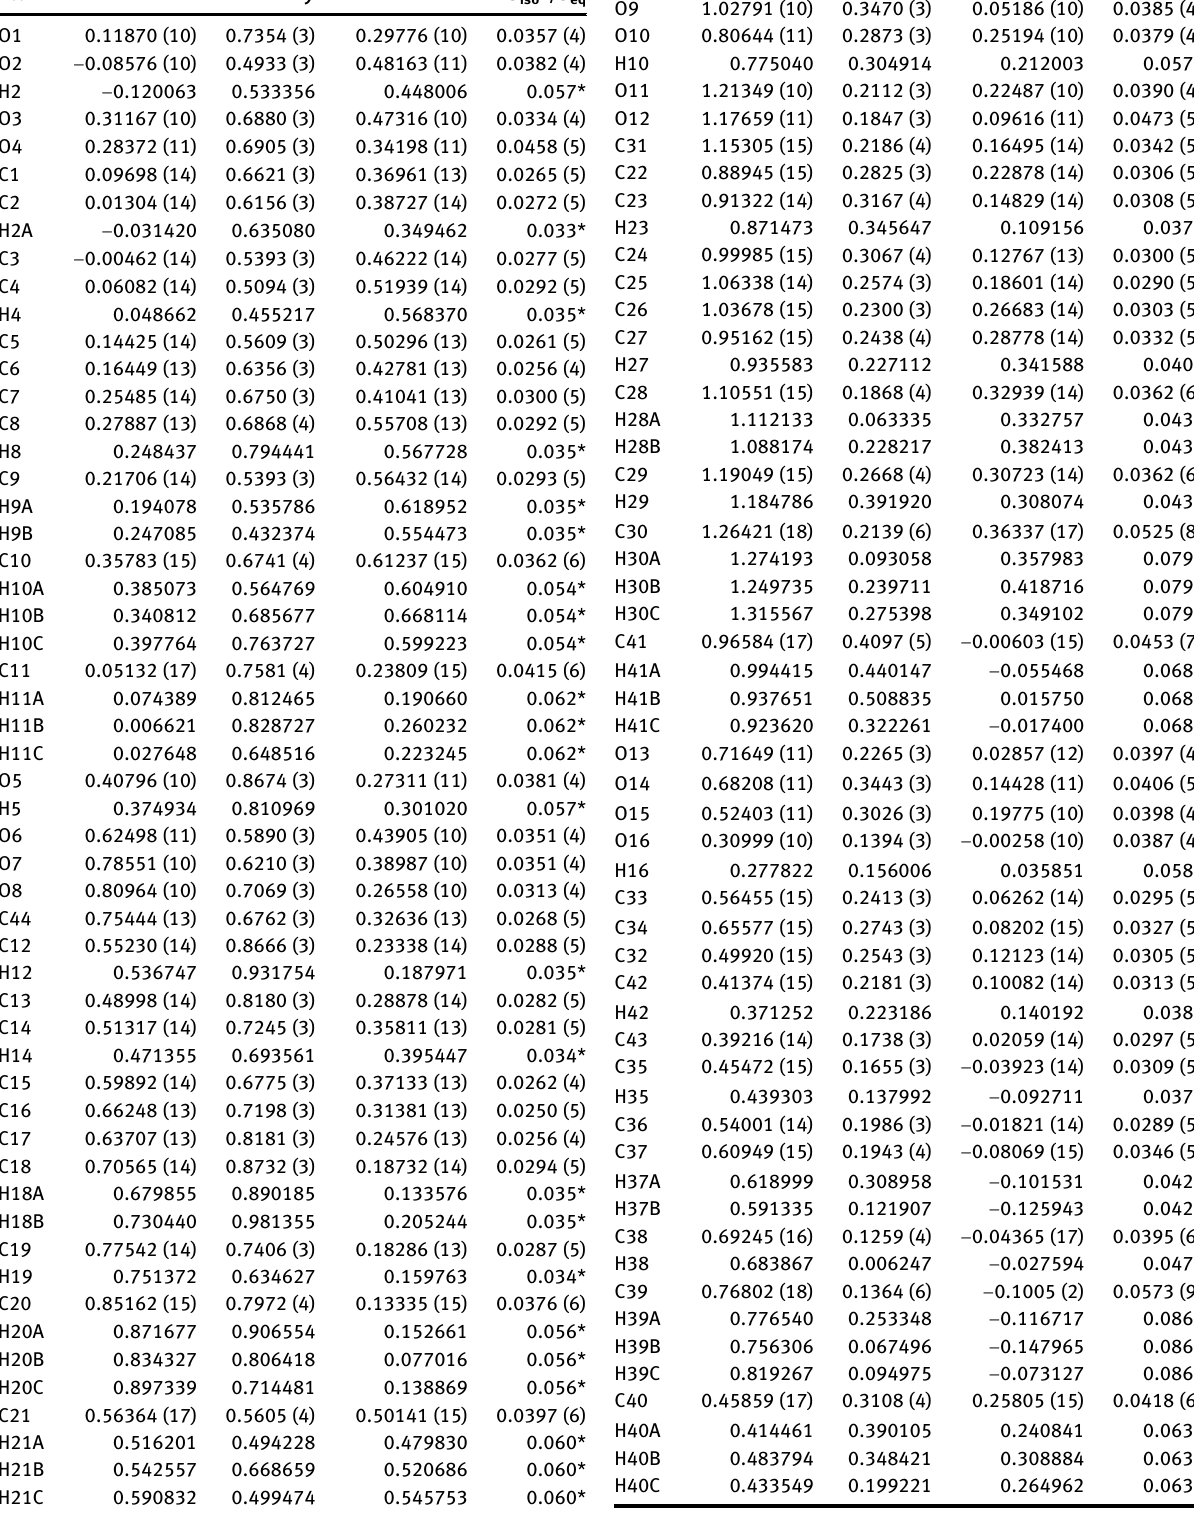
Table  : Fractional atomic coordinates and isotropic or equivalent isotropic displacement parameters (Å 